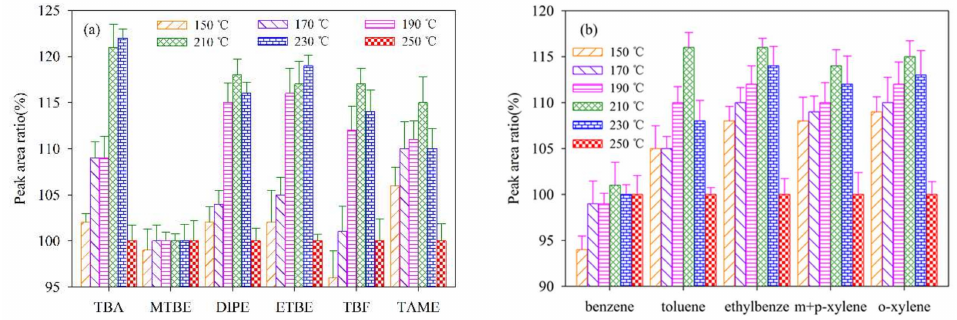
Figure 1. E ff ect of injection port temperature on MS / MS detection signal intensities of the twelve analytes (20 µ g / L). The peak area at the injection port temperature of 250 ◦ C is used as a reference (100%). ( a ) the peak area ratio of TBA, MTBE, DIPE, ETBE, TBF, and TAME; ( b ) the peak area ratio of